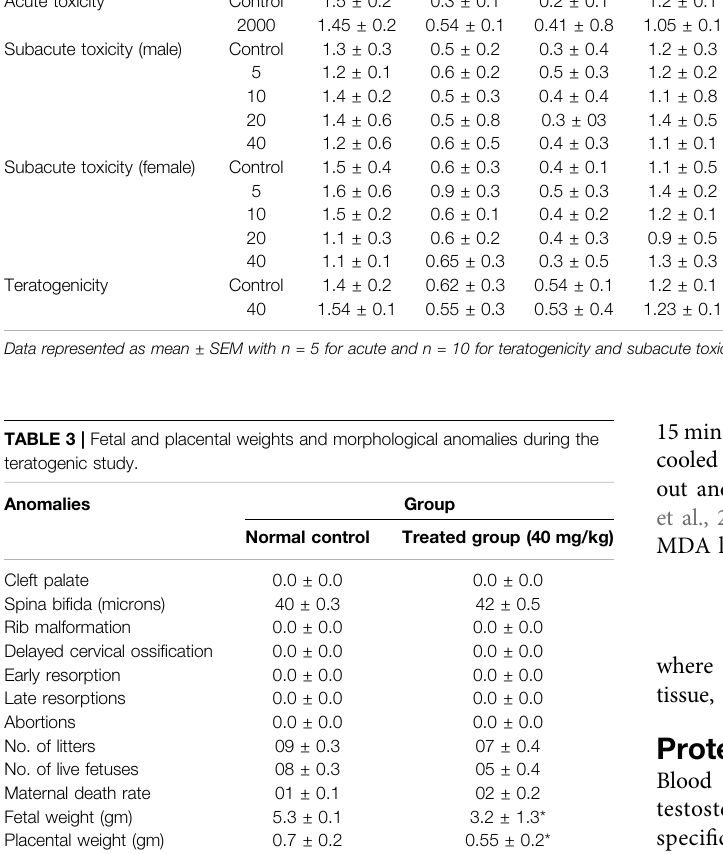
Malondialdehyde tissue homogenate. Shake well and incubate the mixture for